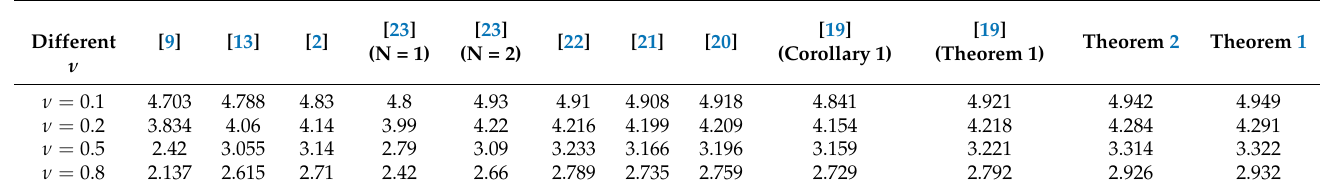
Table 2. As for different ν , MUAB of ϕ obtained by simulation in Example